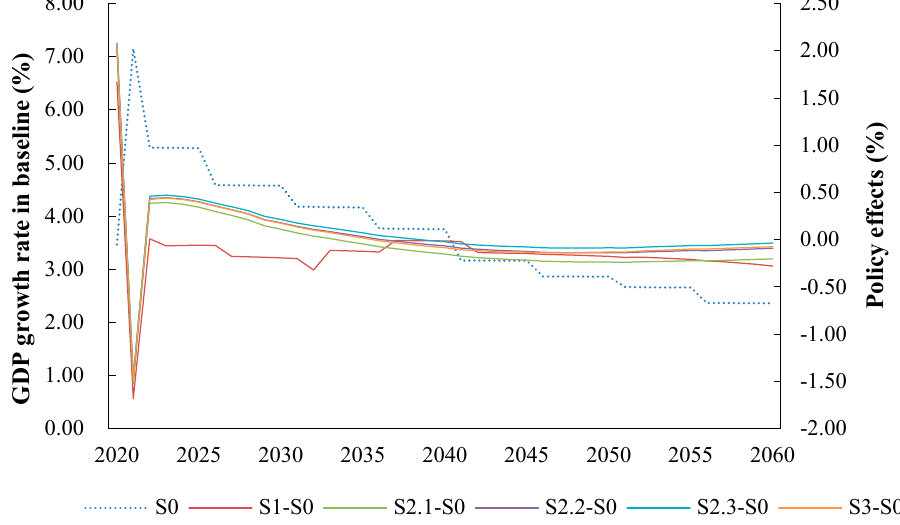
Figure 5. GDP growth rate projection from 2020–2060 under different scenarios in China.